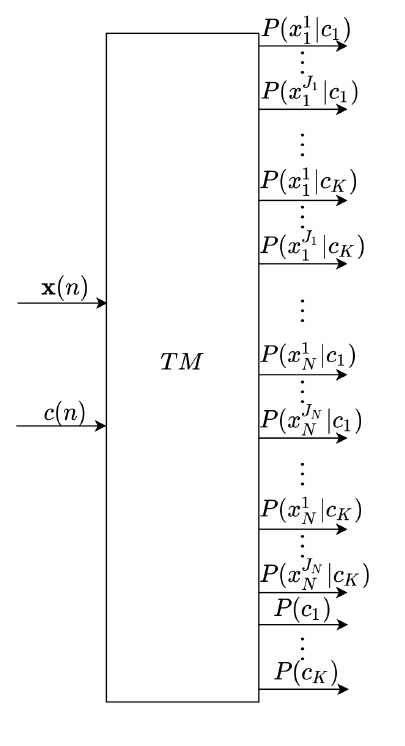
Figure 2. General architecture of the